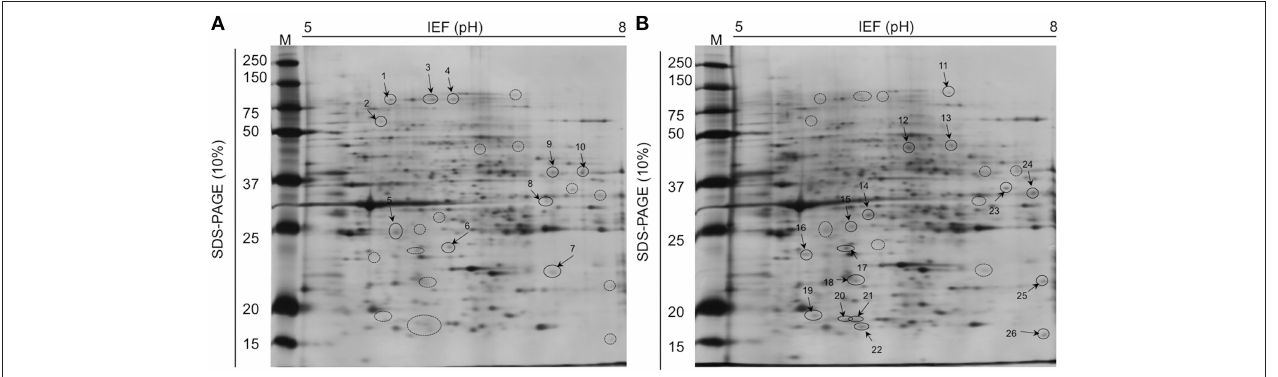
FIGURE 8 | Two-dimensional gel electrophoresis comparisons of total proteins isolated from Steinernema diaprepesi maintained for 48h in sand at 6% moisture (A) and 18% moisture (B). IPG strips of linear pH 5–8 were used for isoelectric focusing and the SDS-PAGE was performed in 10% acrylaMIDE. Protein molecular weight standards are shown on the left. Spots of statistically significant differences ( P < 0.05) between the condition were selected to be identified using mass spectrometry and listed in Table 1 . Spots labeled 1–10 were proteins expressed at highest levels in 6% moisture sand, those from 11 to 26 were expressed at higher levels in 18% moisture